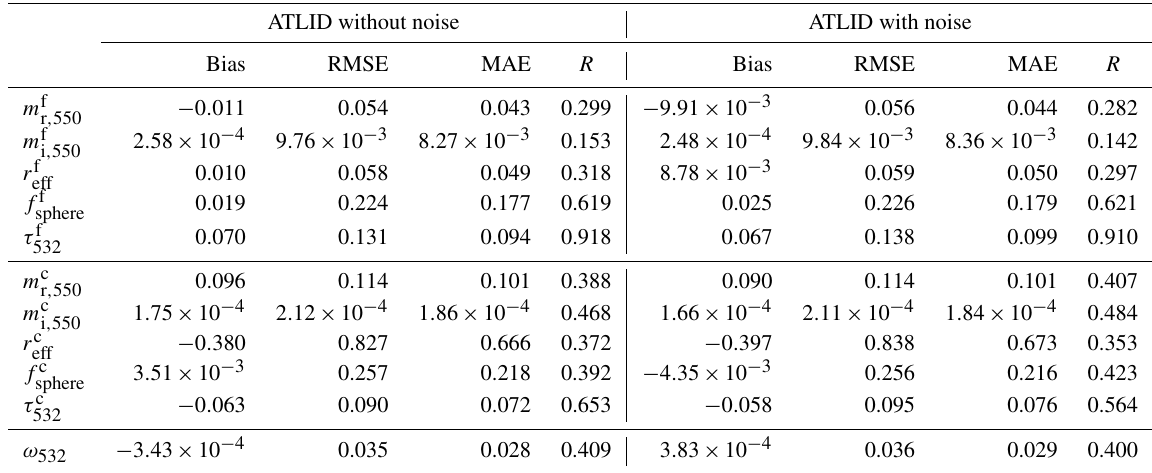
Table 6. Results for retrievals with the Earthcare ATLID configuration with and without noise. Note that the refractive indices would be the same for 355nm, the wavelength at which ATLID is planned to